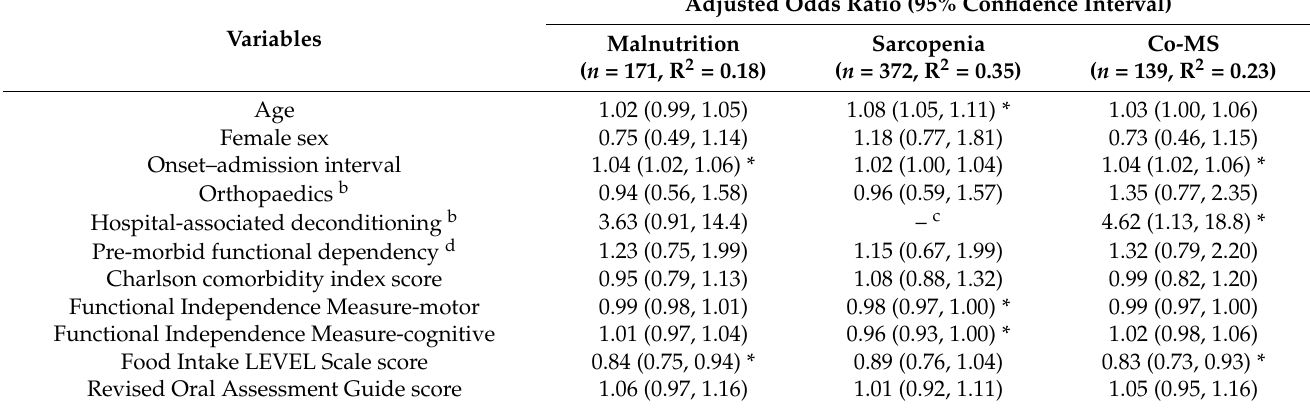
Table 3. Adjusted odds ratios for malnutrition, sarcopenia, and coexistence of malnutrition and sarcopenia (Co-MS) among 595 rehabilitation patients a .